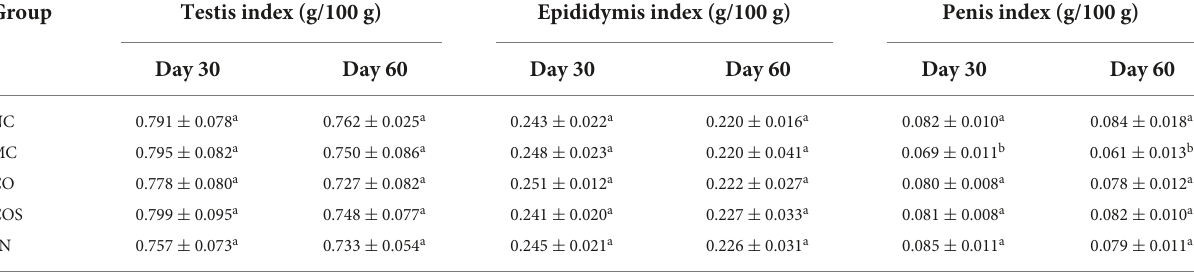
TABLE 1 Sexual organ indices of hyperlipidemia-induced reproductive damage